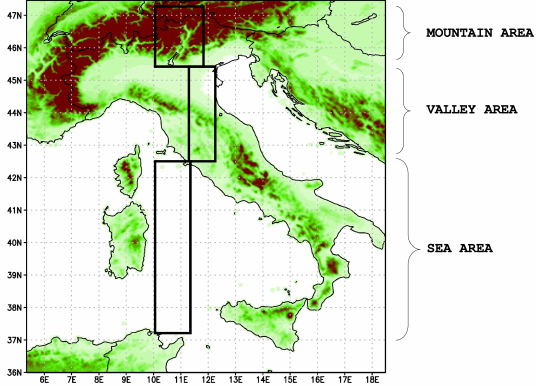
Figure A3. Selected areas (Sea, Valley, Mountain) used for the validation of the atmospheric fields of